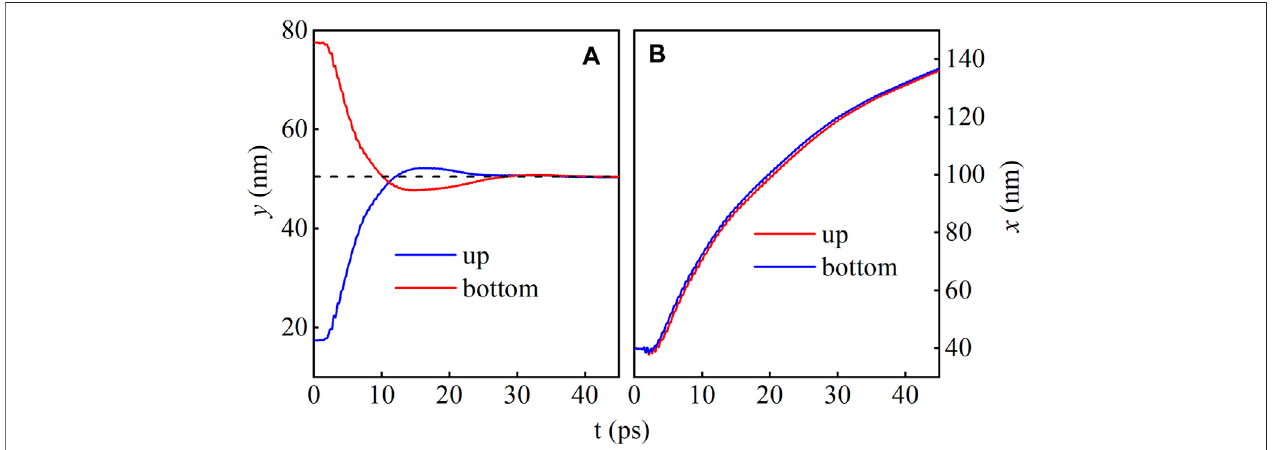
FIGURE 3 | The evolution of the (A) y and (B) x coordinates of the AFM skyrmions. The black dashed line represents the intersection of the spin wave sources.